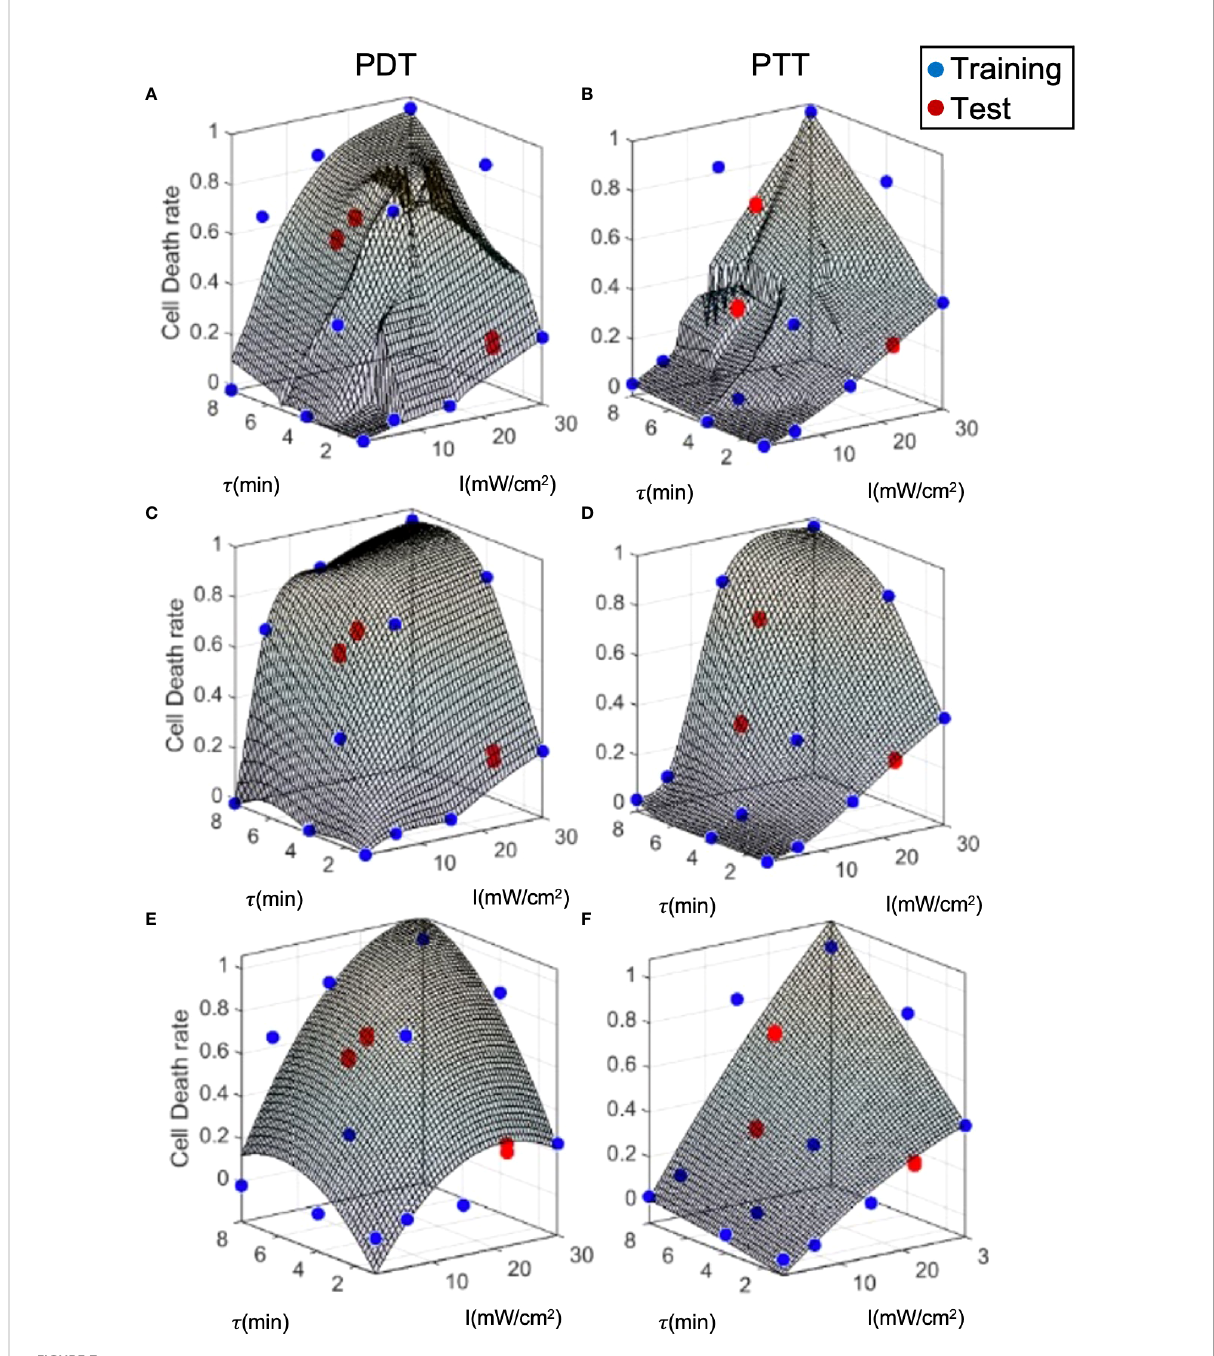
FIGURE 7 Model prediction error analysis for the three prediction methods. (A, B) LOWESS regression, (C, D) interpolation, (E, F) analytical